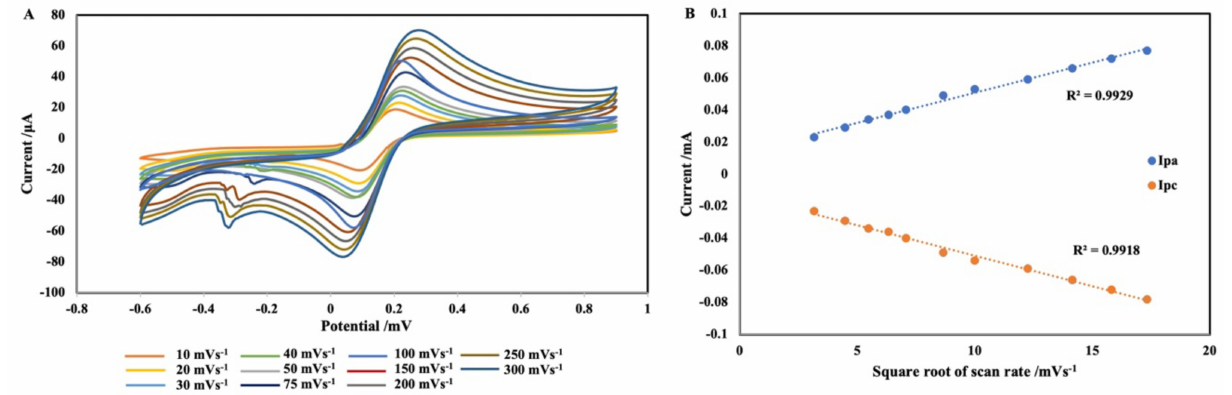
Figure 6. ( A ) Cyclic voltammograms of PDA/SPCEs at different scan rates from 10 to 300 mVs − 1 using 5 mM [Fe(CN) 6 ] 3 − /4 − in phosphate-buffered saline (PBS) as redox probe. ( B ) plot between anodic (Ipa) and cathodic (Ipc) peak currents vs. square root of the scan rate (mVs − 1